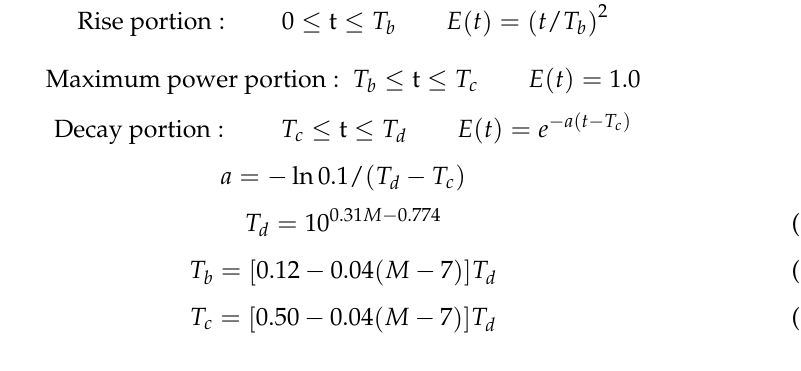
Figure 11. Duration envelope function.